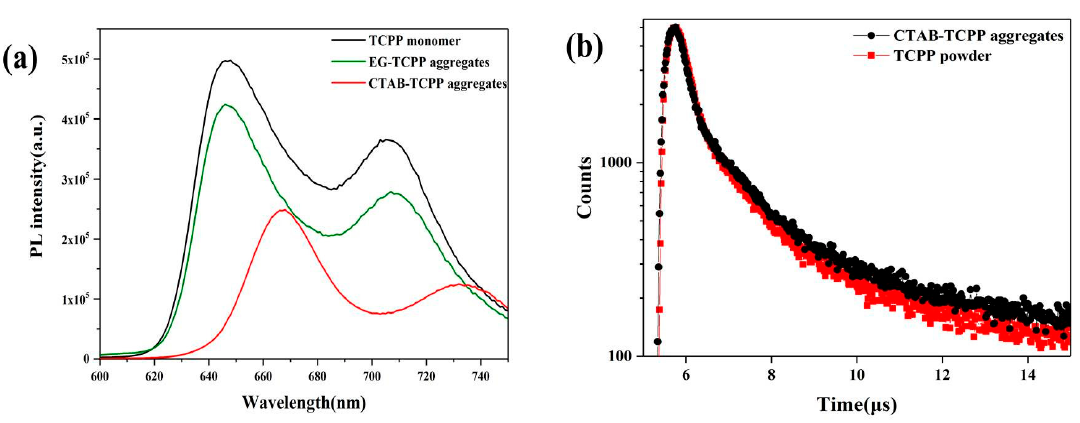
Figure 3. ( a ) The photoluminescence spectra and ( b ) time-resolved fluorescence decay curves of TCPP aggregates.